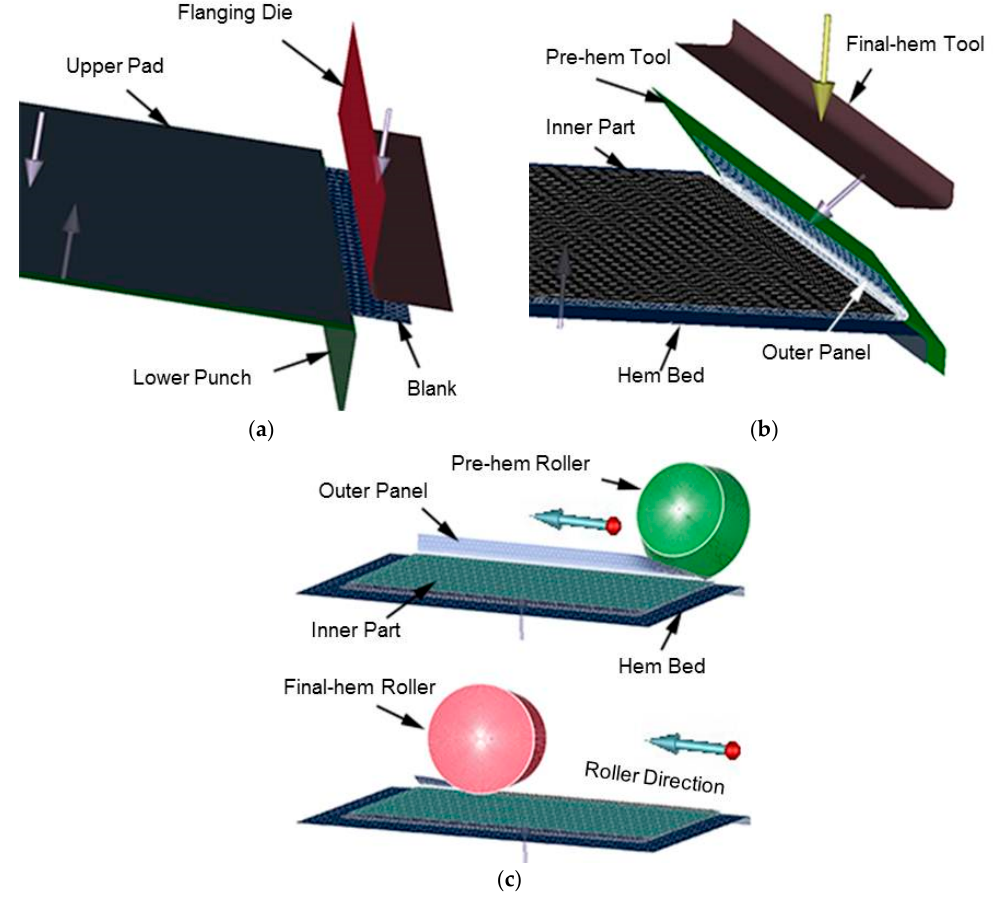
Figure 9. Geometric model of the forming operations: ( a ) flanging; ( b ) die hemming; and ( c ) roller hemming.